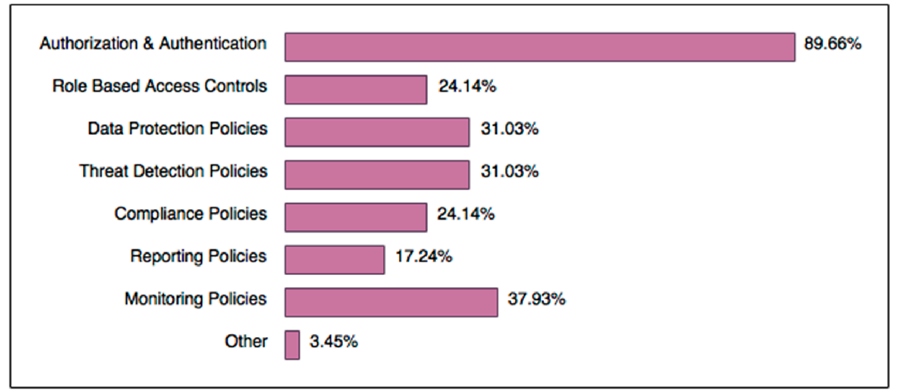
Figure 4. Network policies enforced by Businesses for BYOD security.